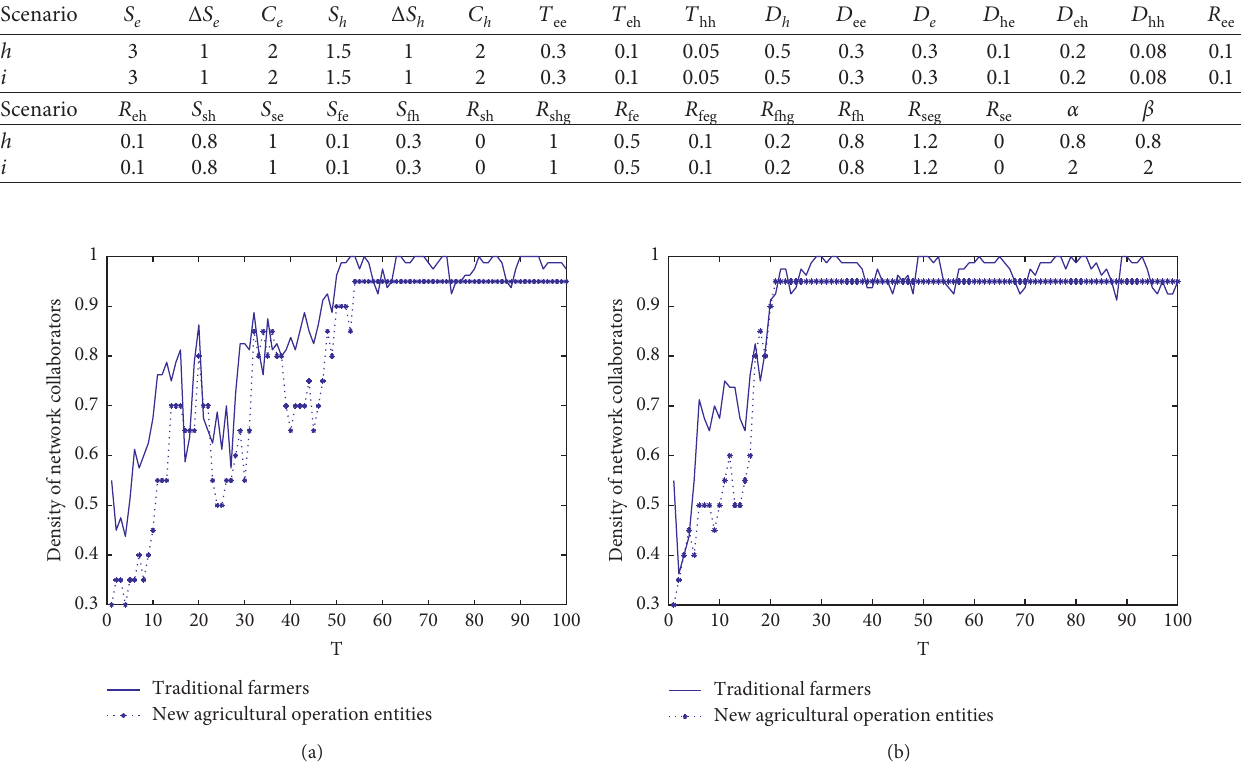
Figure 2: Evolution of scenarios h and i on green agricultural production network under the government guidance mechanism.